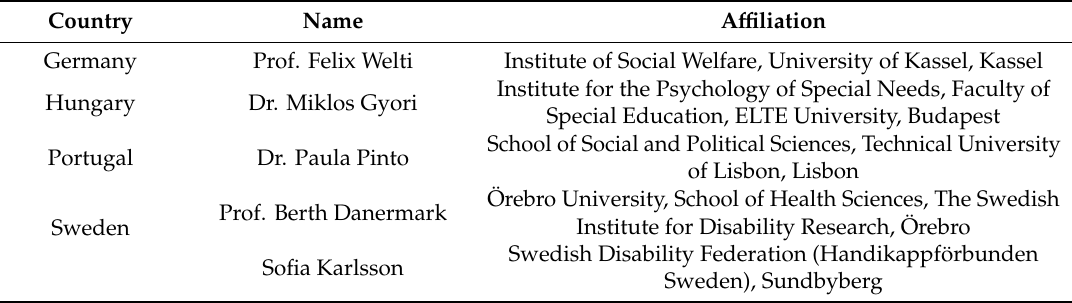
Table A2. List of experts